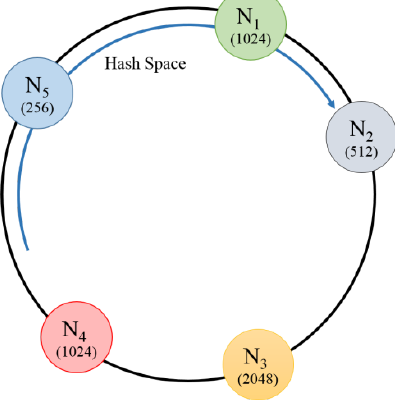
Figure 3. Initial nodes using the existing chord scheme.